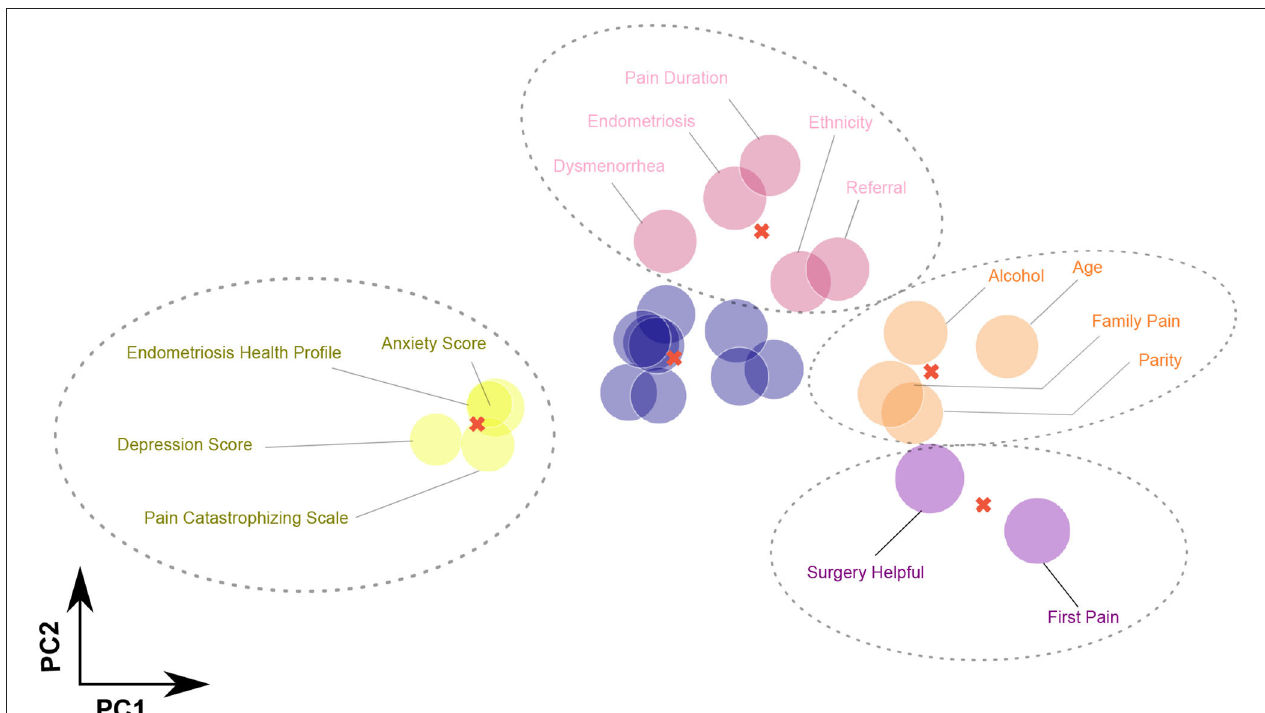
FIGURE 5 | Centroid-based clustering (CBC) analysis of all 25 factors in the Pelvic Pain and Endometriosis database using five clusters. Four factors (Pain Catastrophizing Scale, anxiety score, depression score, and Endometriosis Health Profile) are formulated in one cluster with respect to chronic pelvic pain (CPP). Also, four factors (age, family history of chronic pain, parity, and alcohol use per week) are formulated in one cluster with respect to CPP. Nine factors [body mass index (BMI), infertility, trauma, deep dyspareunia, smoking, irritable bowel syndrome, painful bladder syndrome, pelvic floor tenderness, and abdominal wall pain] are formulated in one cluster with respect to CPP. Interestingly, age at first pain and history of surgery are correlated with each other with respect to